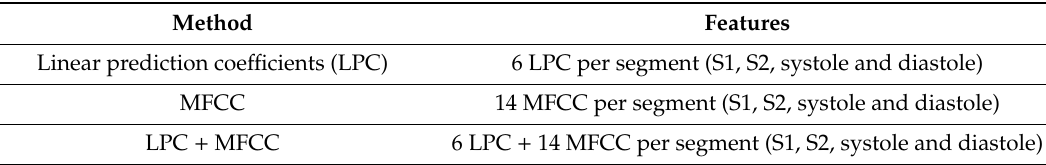
Table 9. Features used in [27].